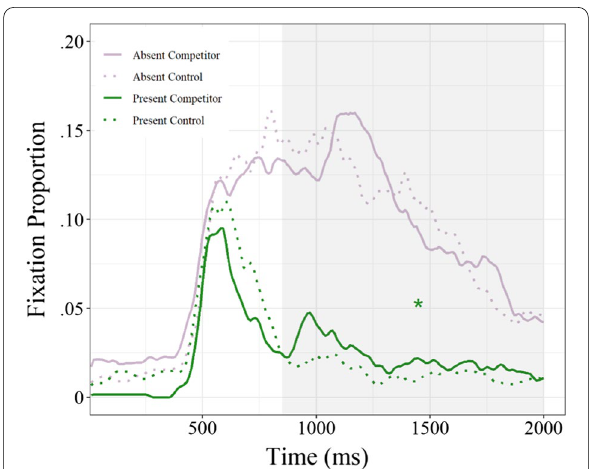
Fig. 2 Timecourse of visual fixations to competitor (solid) and control objects (dotted) in the target-absent (purple) and target-present (green) conditions. Competitor and control fixations were longer and more frequent when the target was absent. When the target was present, competitor fixations were longer and more frequent than control fixations from 850 ms following presentation of the competitor (shaded area)